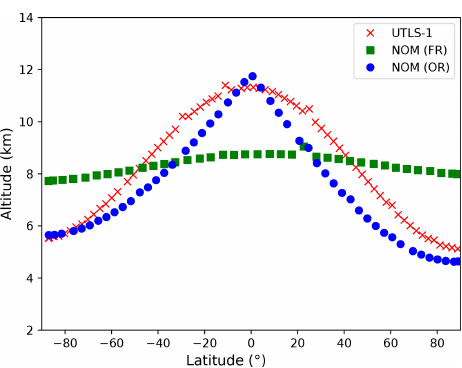
Figure 1. Altitude of the lowermost tangent point as a function of latitude for the NOM observation mode of the FR mission (green) and for the NOM (blue) and UTLS-1 (red) observation modes of the OR part of the